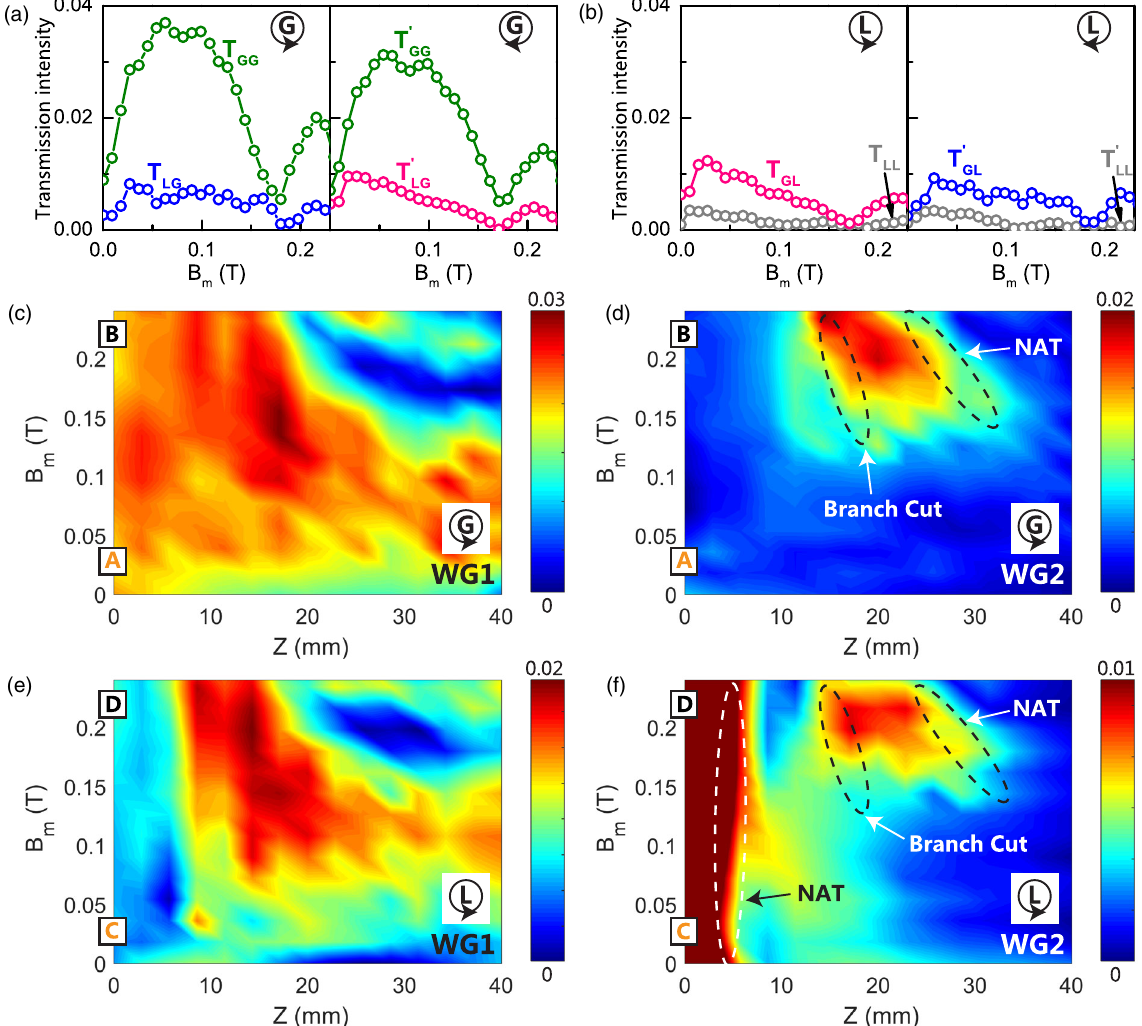
FIG. 10. (a), (b) Experimentally measured transmission intensities at 11.5 GHz as a function of B (b) as the injection. The system parameters are W ¼ 8 mm, H ¼ 4 mm, and g ¼ 0 . 5 mm. A microwave absorber stronger than the one used in Fig. 5(a) with the dimensions of approximately 3 × 2 × 400 mm is attached to waveguide-2. (c) – (f) Experimentally measured surface electric field intensities along the waveguiding direction at 11.5 GHz for different values of B loops with a gain mode as the injection are shown in (c) and (d) for waveguide-1 (WG1) and waveguide-2 (WG2), respectively, while results for counterclockwise loops with a loss injection are shown in (e) and